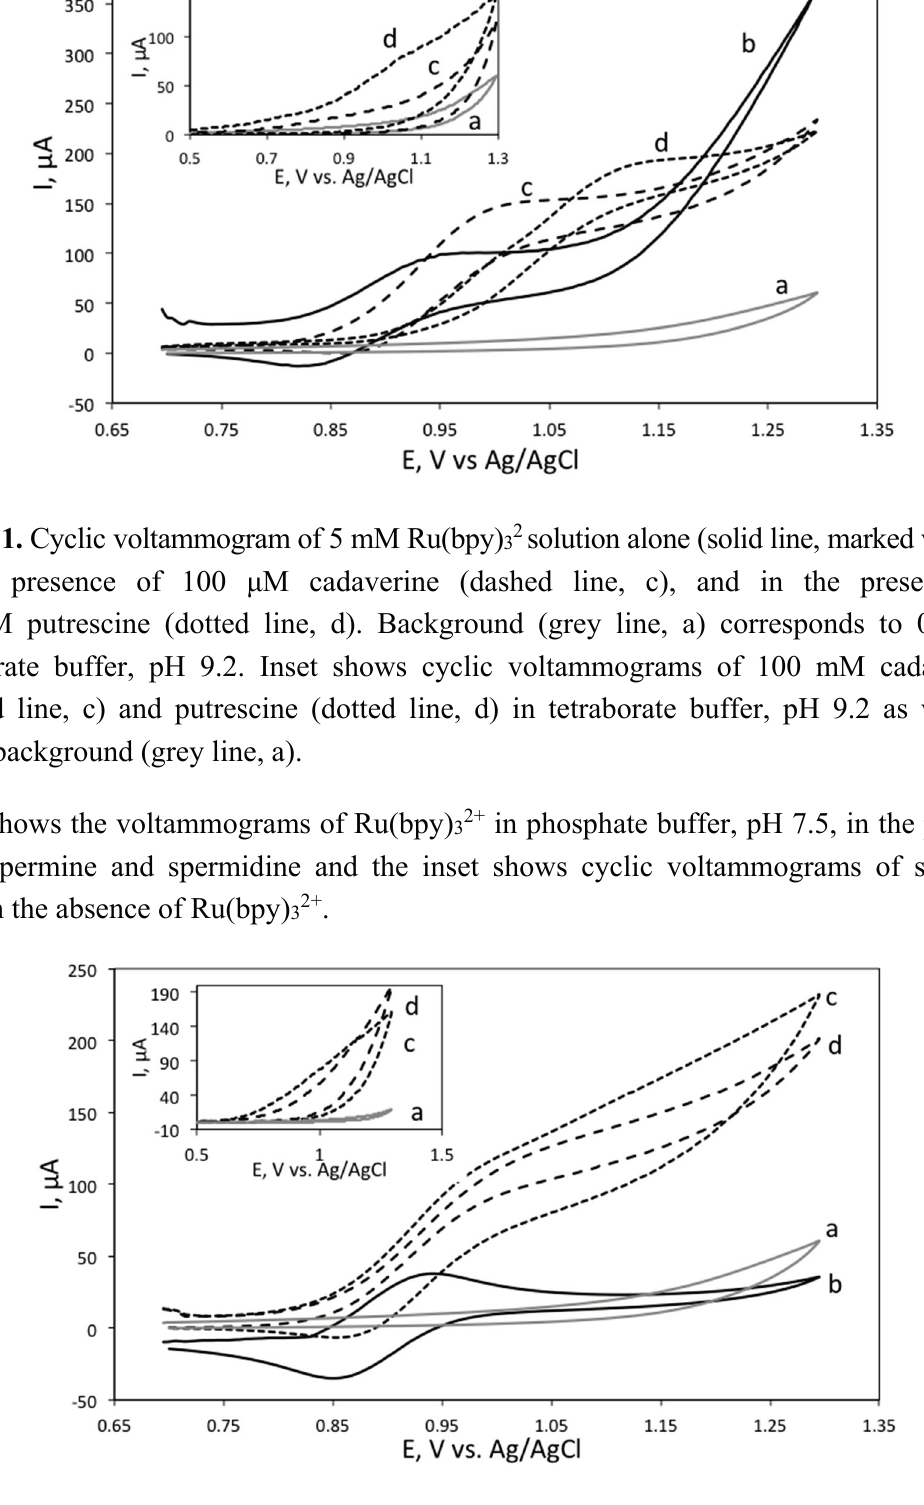
Figure 2. Cyclic voltammogram of 5 mM Ru(bpy) 3 2 in 100 mM phosphate buffer, pH 7.5 (solid line, b), in the presence of 10 μ M spermine (dotted line, c) and in the presence of 10 μ M spermidine (dashed line, d). Inset shows cyclic voltammograms of 100 mM spermine (dotted line, c) and spermidine (dashed line, d) in phosphate buffer, pH 7.5. The background (grey line, b) corresponds to 100 mM phosphate buffer, pH